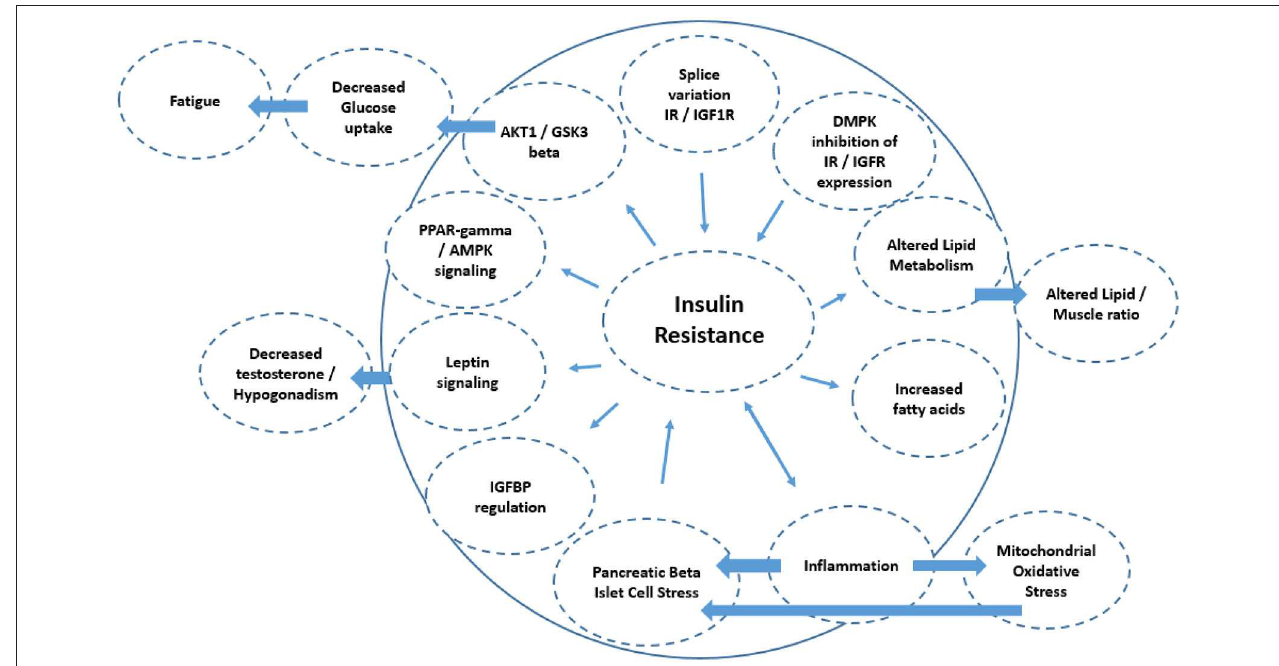
FIGURE 3 | Schematic diagram of the mechanisms associated with insulin resistance. The directionality of the arrow indicates if it is a cause or consequence of insulin resistance. This includes splice variation of IR/IGF1 receptor expression (e.g., IR-A isoform increase vs. IR-B), leading to insulin resistance. Diminished cell membrane IGFR and IR expression could result from the DMPK repeat length expansions blocking the nuclear pores, and also result in insulin resistance. Alterations in lipid metabolism as a consequence of insulin resistance may also lead to altered lipid/skeletal muscle ratios, as is seen in DM1. Reduced insulin sensitivity is also associated with diminished muscle protein synthesis, resulting in decreased muscle mass. Inflammation has a bidirectional relationship with insulin resistance and may in part underlie atherosclerosis in DM1. Mechanistically, inflammation increases mitochondrial oxidative stress and stress at the level of the pancreatic beta islet cells which also increases insulin resistance. Decreased IGFBP expression also reduces insulin sensitivity by reducing the half-life of any insulin-IGFBP complex to bind to the IR/IGF receptors. Insulin resistance also acts to alter leptin signaling which amongst others can regulate testosterone tone. Insulin resistance can also act at the level of (1) PPAR γ /AMPK signaling and (2) AKT1/GSK3 β signaling thereby regulating glucose turnover which may be linked to fatigue in